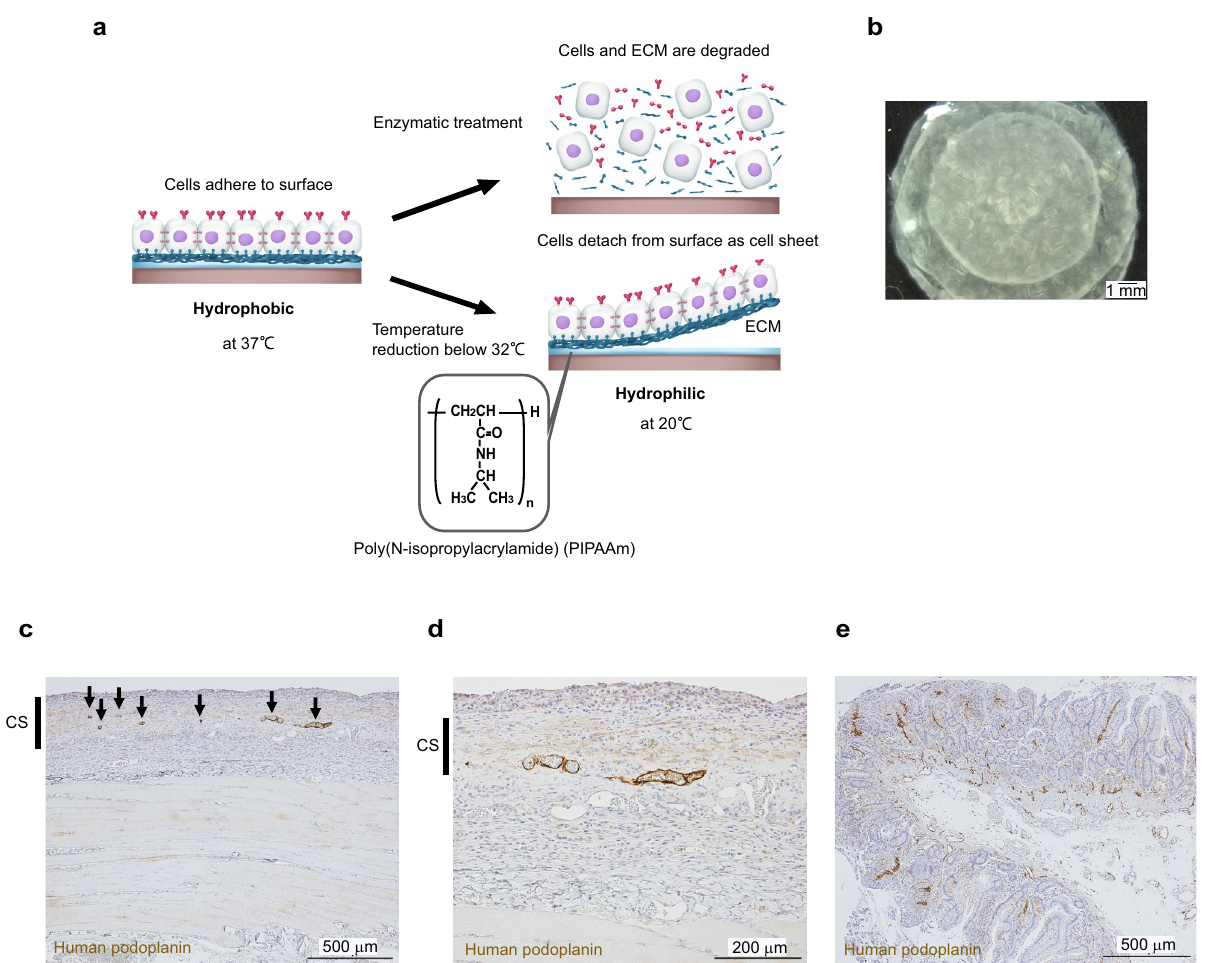
Figure 3. Lymphatic vessel-like structures were evident in a three-layered LEC/ASC sheet (1:4 ratio) 2 weeks after transplantation onto rat gluteal muscle. ( a ) Temperature-responsive culture dish coated with Poly( N - isopropylacrylamide) (PIPAAm), temperature-responsive polymer used to construct cell sheet. At temperature of 37 °C, cells adhere to surface of dish, and temperature decreased to 20 °C enable cells detach from dish preserving their cell–cell junctions, cell surface proteins and extracellular matrix without need of enzymatic treatment which breaks cell–cell junctions. ( b ) Observation of three cell sheets stacked before implantation by stereo microscope. ( c ) Three LEC/ASC sheets were stacked and transplanted onto rat gluteal muscle in vivo, and immunostaining for podoplanin was performed 2 weeks later. The low-power image shows LECs positive for human podoplanin. CS cell sheet. ( d ) High-power image showing a few lymphatic vessel-like structures composed of LECs. ( e ) Positive control image of human podoplanin in human small